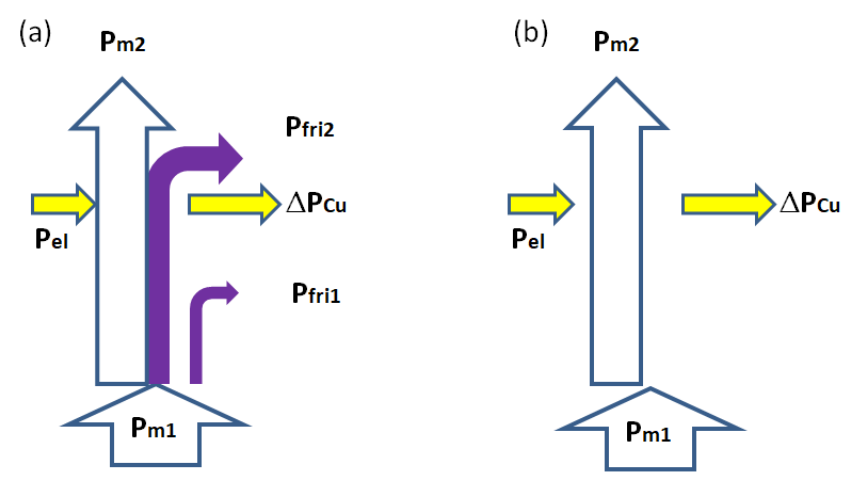
Figure 8. Power-flow diagram ( a ) in steady continuous-duty state with no slippage: ( b ) case study considered in the paper (mechanical losses P fri 1 and P fri 2 are neglected; heat is transferred mainly to surrounding air and because of that it slightly influences temperature in clutch working regions including MR fluid).